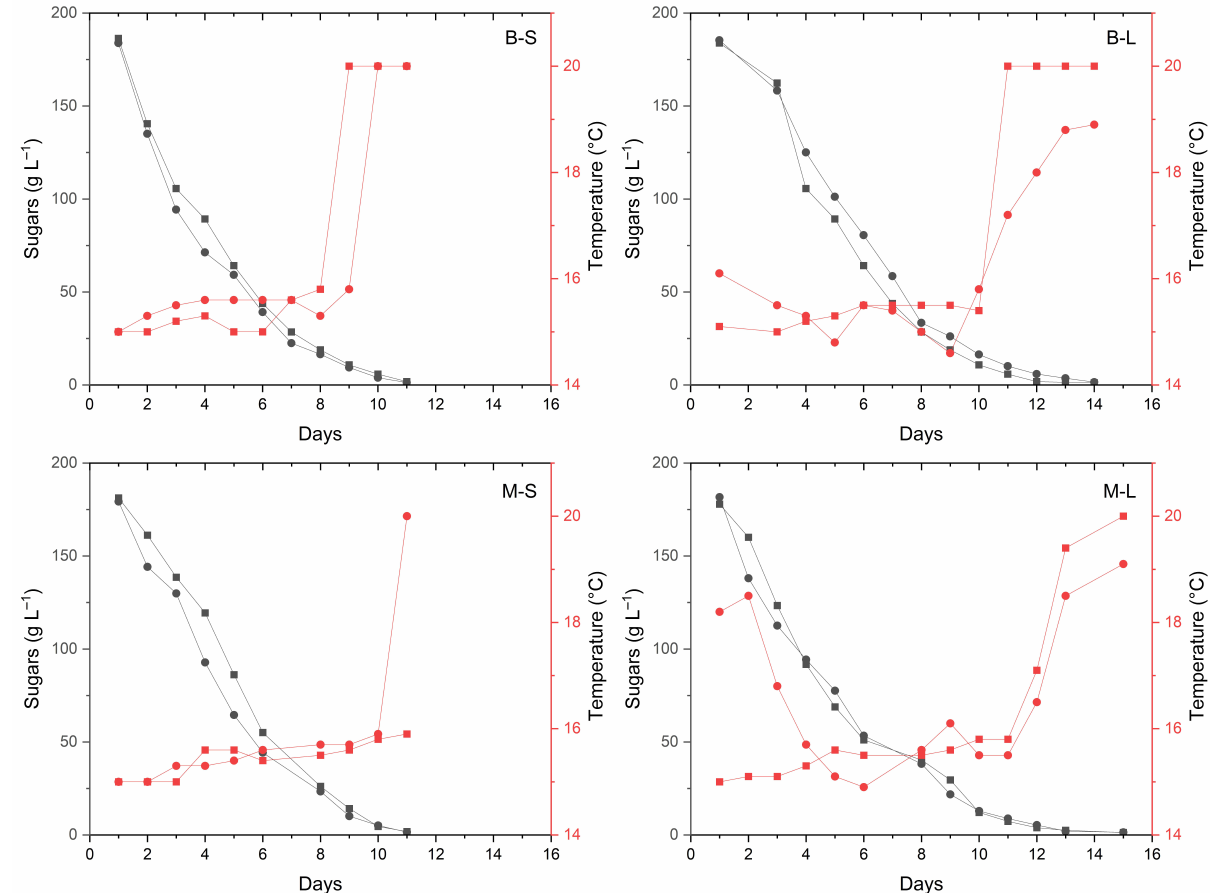
Figure 1. Fermentation curves of the wines obtained by the combination of grape cultivars (M—Minutolo, B—Bombino) and yeast starters (S— Saccharomyces cerevisiae , L— Lachancea termotolerans ). Black lines and left y -axis: sugar consumption; red lines and right y -axis: temperatures. The two replicate fermentations per each combination of cultivar/starter are plotted independently and identified with circles and squares,